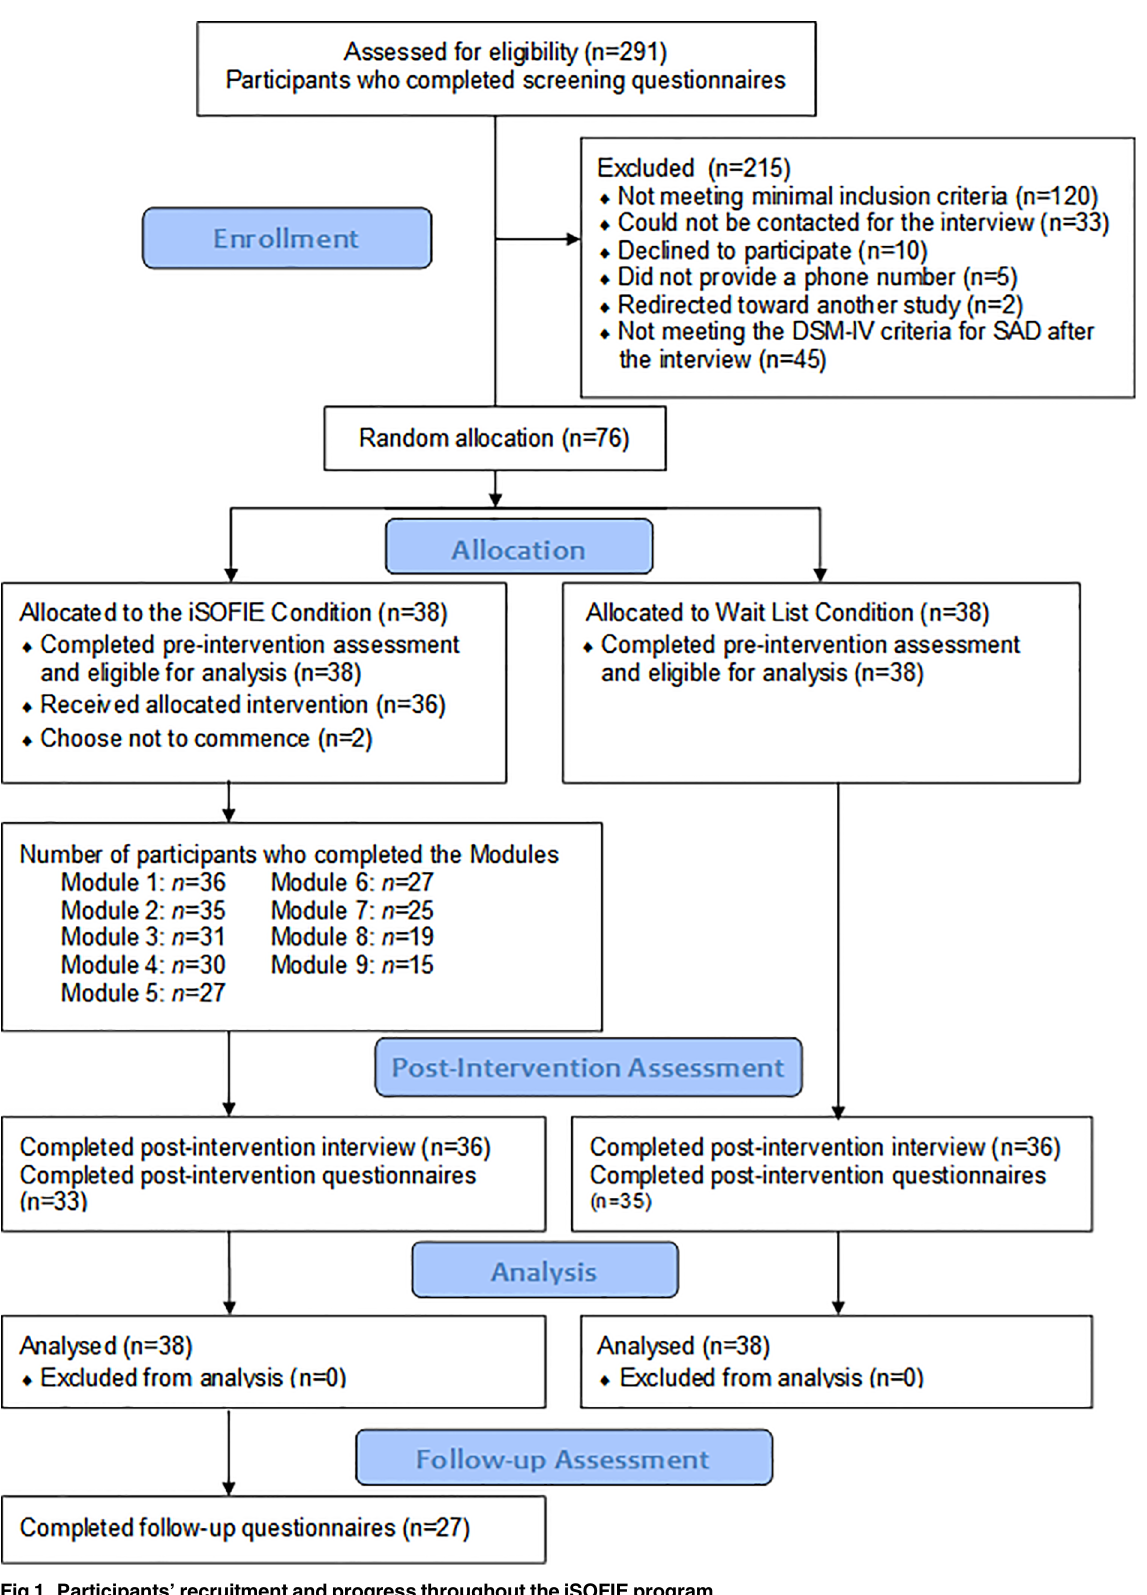
Fig 1. Participants ’ recruitment and progress throughout the iSOFIE program.